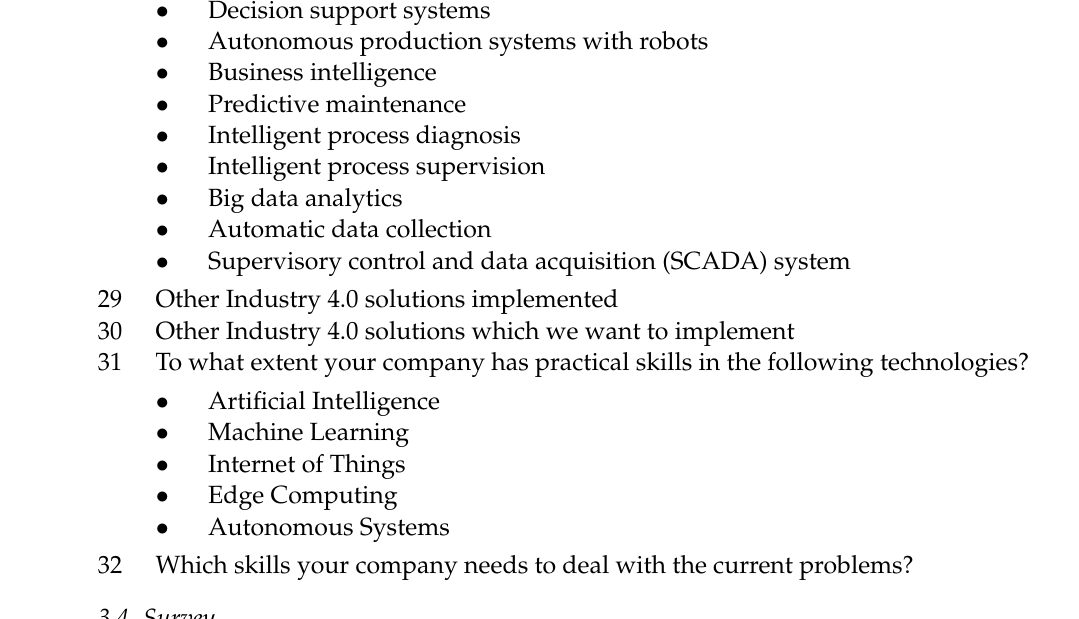
Figure 3. The percentage of questionnaires received from each industry. Figure 4. Number of machines in the analyzed companies.